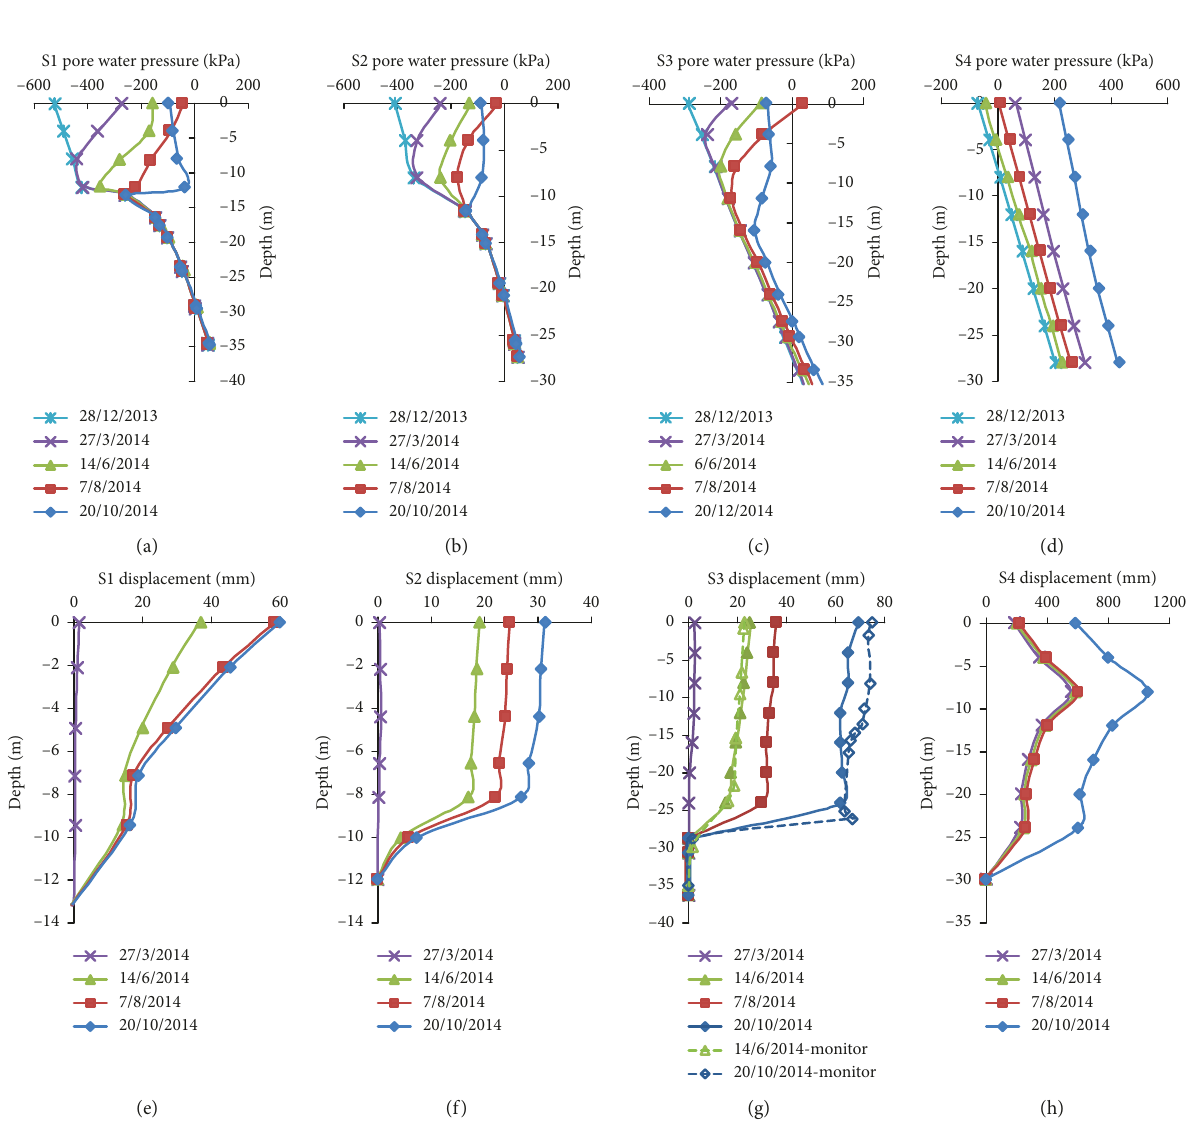
Figure 11: Simulated pore water pressure and displacement over time along sections of the Baishuihe landslide.